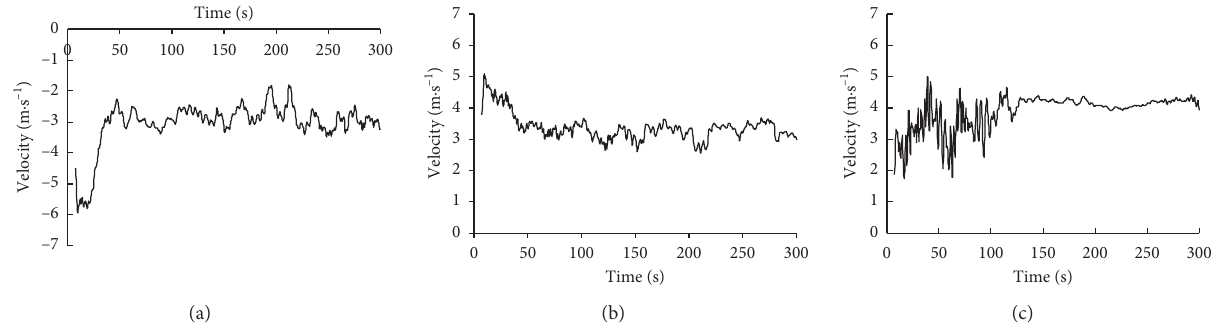
Figure 6: (a) Flow velocity (ms − 1 ) with time at point a of Scheme 2. (b) Flow velocity (ms − 1 ) with time at point a of Scheme 3. (c) Flow velocity (ms − 1 ) with time at point a of Scheme 5.